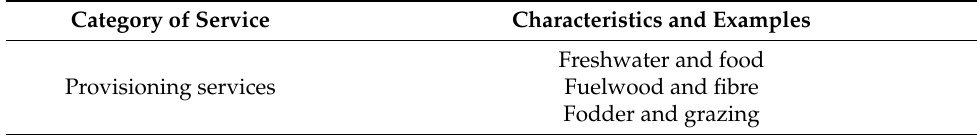
Table 2. Ecosystem services Identified by Co$ting Nature.